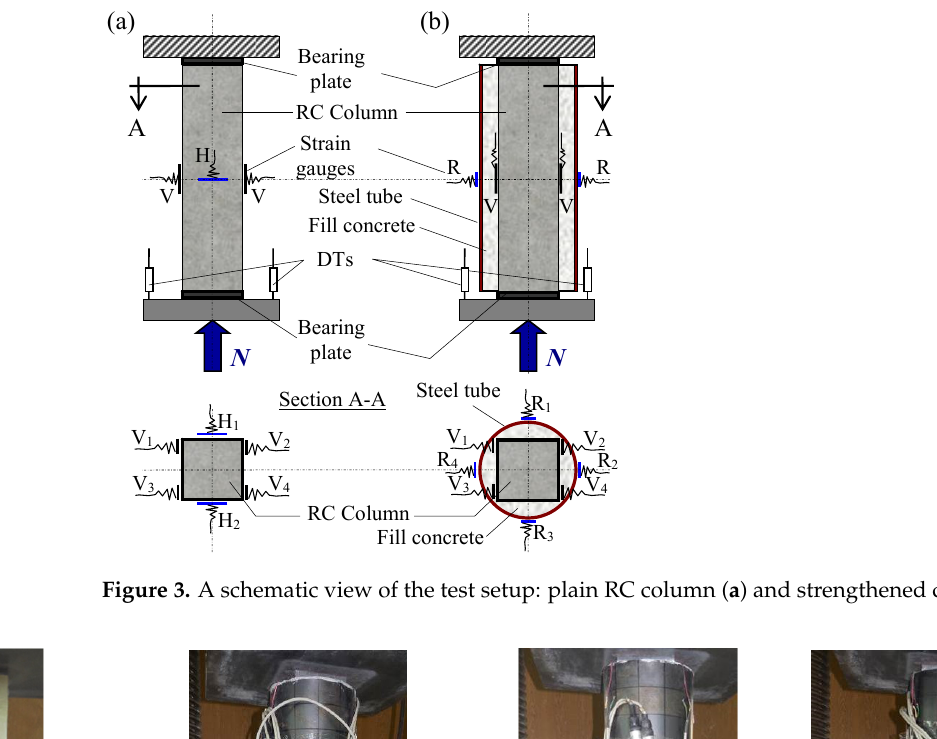
Figure 3. A schematic view of the test setup: plain RC column ( a ) and strengthened column ( b ).